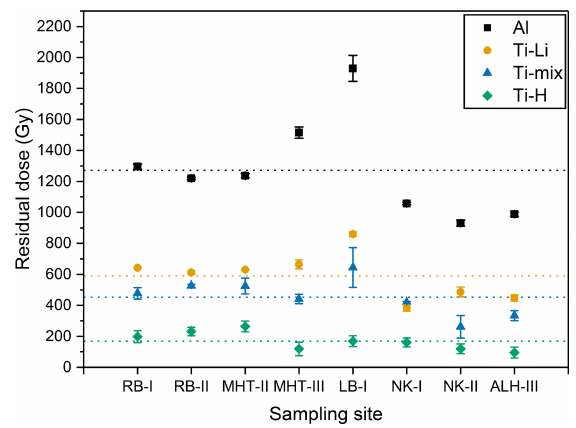
Figure 3. Residual doses of the four different ESR signals for all samples. Dotted lines indicate the mean dose for each